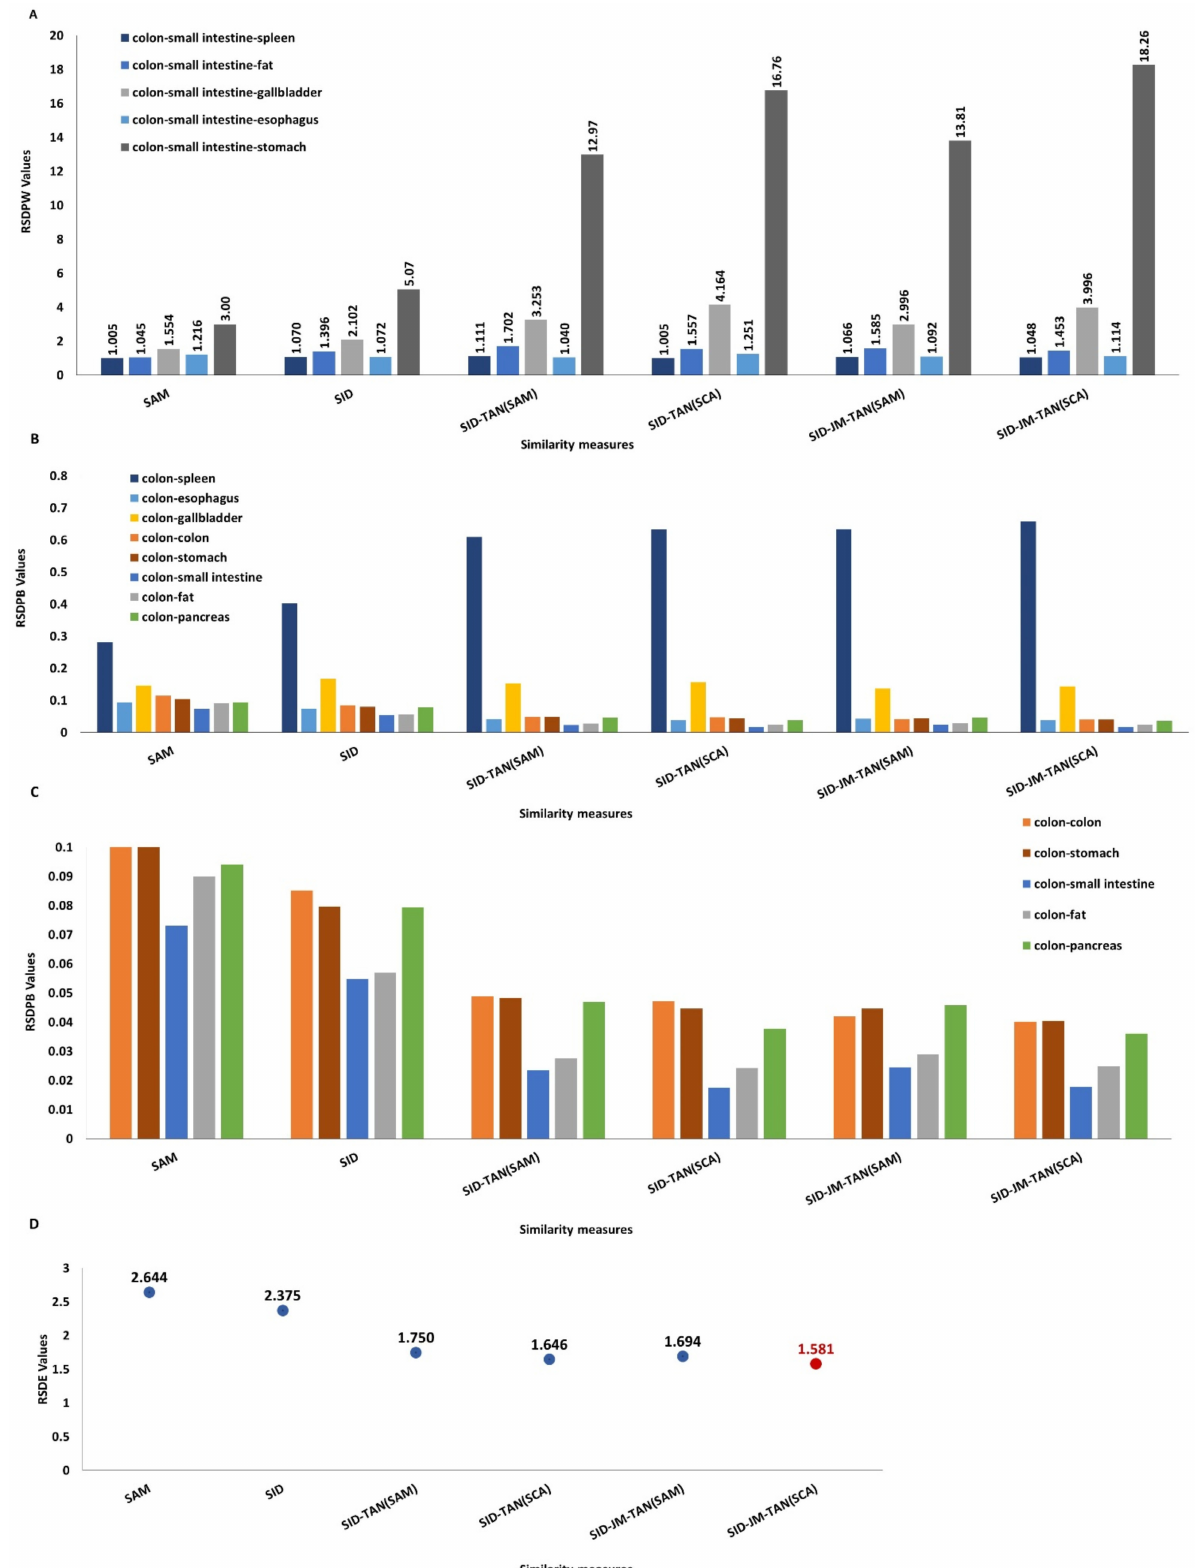
Figure 6. ( A ) RSDPW produced by different similarity measures. ( B ) RSDPB values calculated by different similarity measures. ( C ) RSDPB values produced by the small intestine, colon, fat, pancreas, and stomach. ( D ) RSDE values produced by different similarity measures (reference tissue: